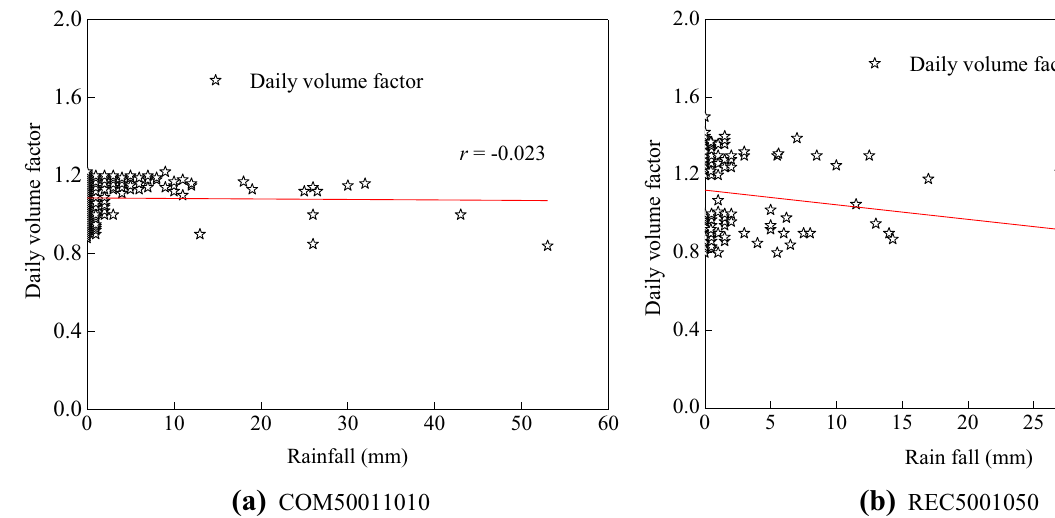
Fig. 4 Effect of rainfall on 24-h traffic counts during summer months